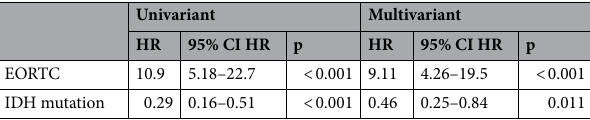
Table 5. Analysis multivariant (parsimonious model).